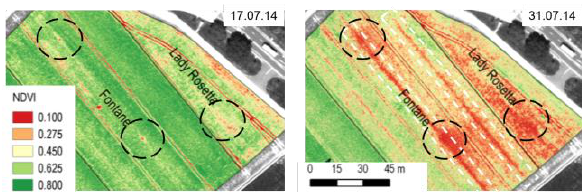
Figure 15. Detail view of potato field NDVI map highlighting the three original sites of potato blight infestation (dotted circles) and the subsequent spreading of the